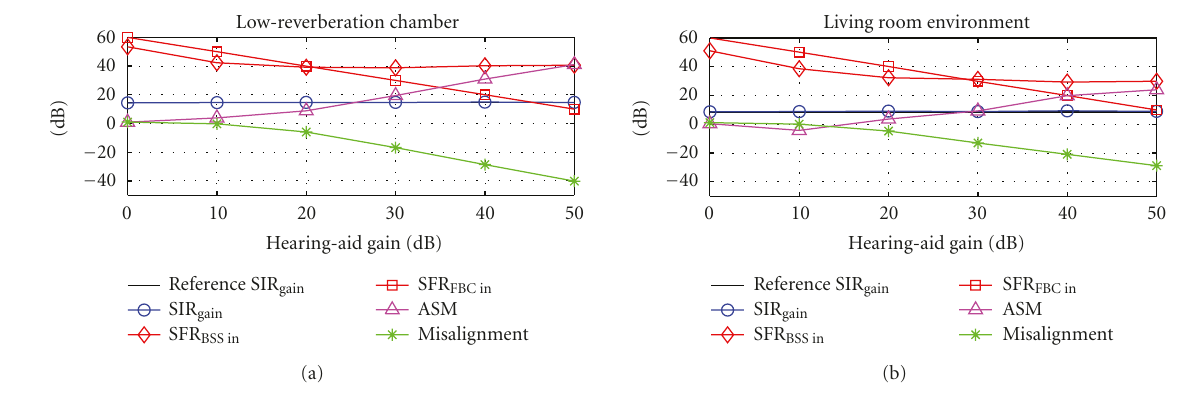
Figure 7: Performance of the AFC-BSS combination in two acoustical environments. The measured FPBs for a vent of size 2mm were